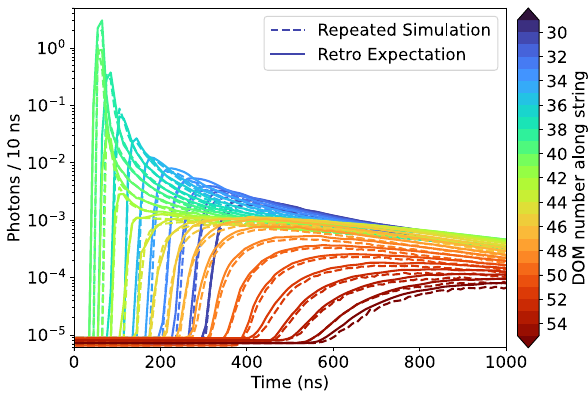
Fig. 7 ExpectedphotontimedistributioninseveralDOMsalongstring 86, for a straight up-going muon with an energy 20 GeV, starting at ( 0 , 0 , − 350 ) m in IceCube coordinates. The dashed lines show the aver- age from 10 7 repeated MC simulations, while the solid lines show the expected distributions based on the tables and event model discussed